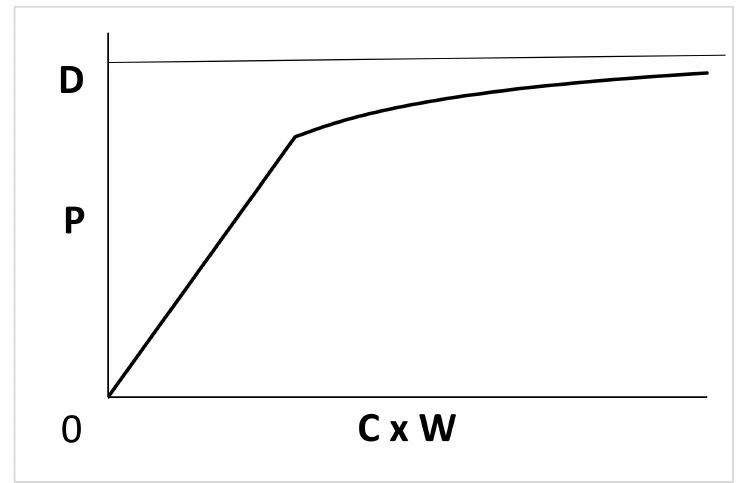
Figure 2. Representation of the Asymptotic